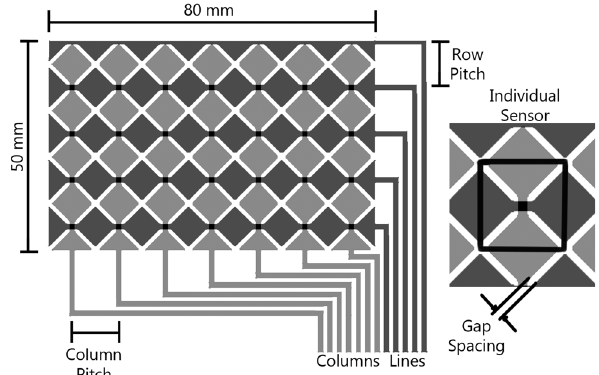
Figure 2: The fl exible touch sensor is made of two layers of lines and columns of electrodes, which combined form a matrix with 5 lines and 7 columns. Each sensitive element is an intersection of a line and a column. Adapted from ref. [ 27 ]